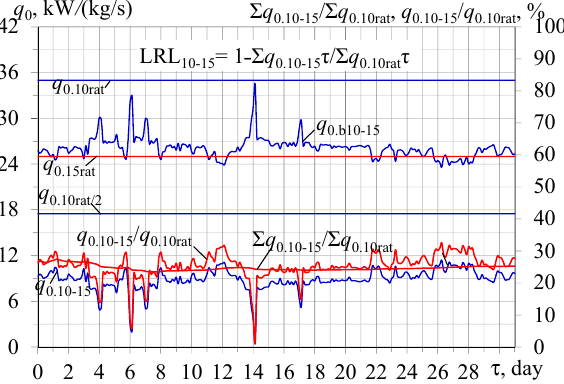
Figure 9. Actual values of refrigeration capacities q 0.10–15 for further air conditioning from 15 to 10 ° С and residual booster values q 0.b10–15 ; relative basic thermal load values q 0.10–15 / q 0.10rat for further air conditioning from 15 to 10 ° С ; corresponding averaged summarized refrigeration energy consumed ∑ ( q 0.10–15 τ )/ ∑ ( q 0.10rat τ ): q 0.b15 = q 0.10rat − q 0.10–15 ; q 0.10–15 = q 0.10 − q 0.15 . As one can see, the values of ratio ∑ ( q 0.10–15 τ )/ ∑ ( q 0.10rat τ ) = 0.25 . . . 0.28 (Figure 9) correspond to the required values of LRL 10–15 = ∑ ( q 0.b10–15 τ )/ ∑ ( q 0.10rat τ ) equal to 0.72 . . . 0.75 (Figure 8) according to the correlation LRL 10–15 = 1 − ∑ ( q 0.10–15 τ )/ ∑ ( q 0.10rat τ ) as settled